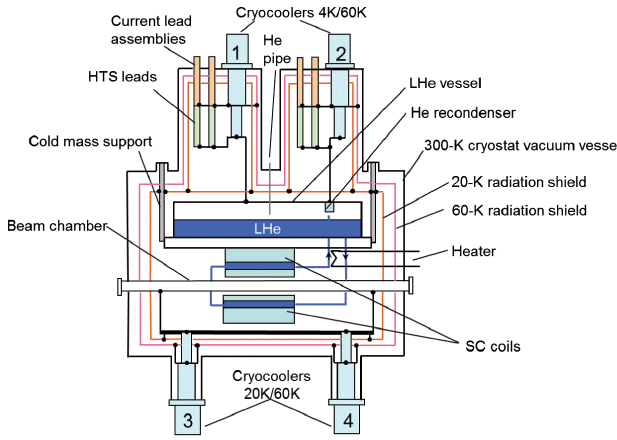
FIG. 6. SCU0 cooling scheme concept.